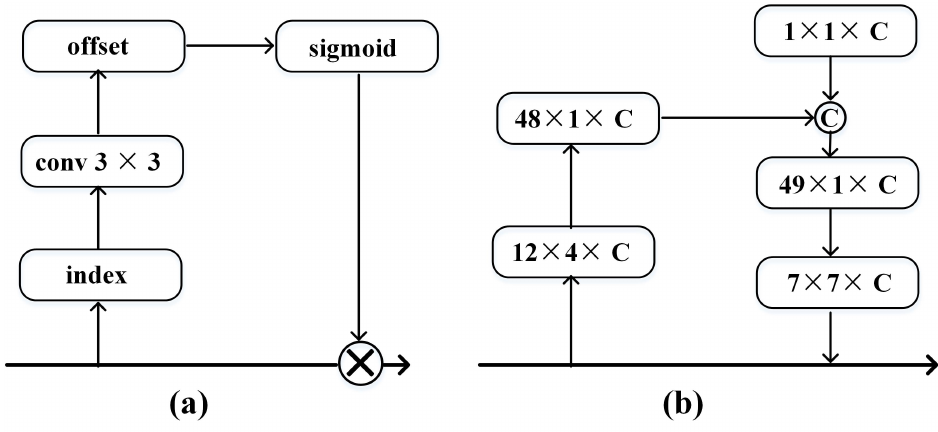
Figure 7. ( a ) The step of transformation operation; ( b ) The process of deformation